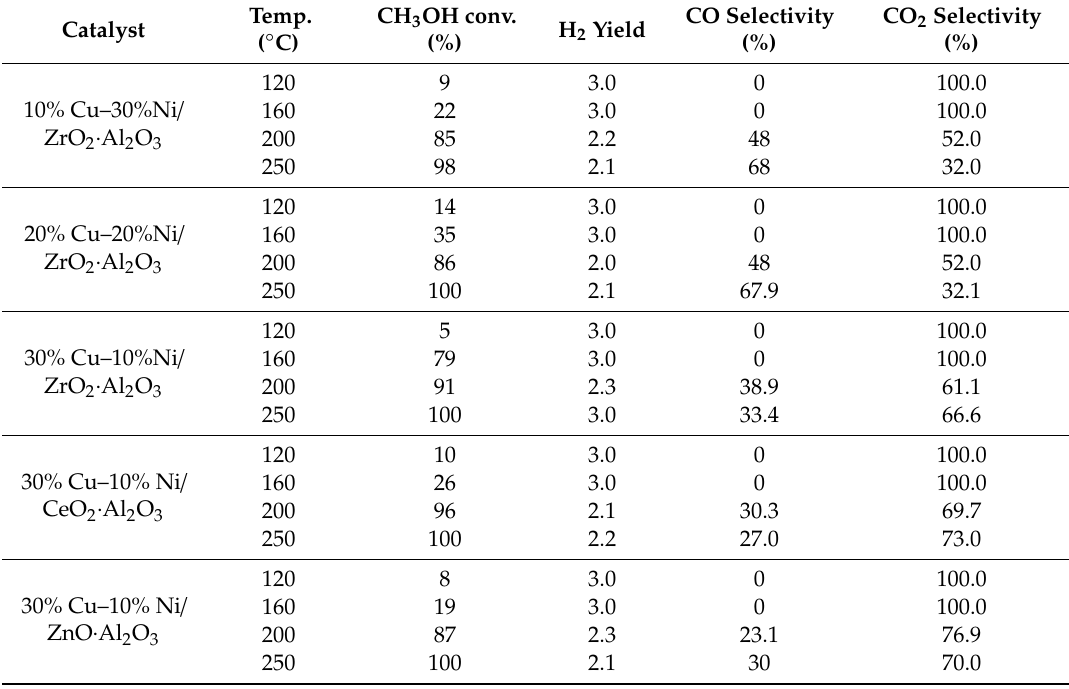
Table 1. Results of the oxidative steam reforming process for calcined bimetallic catalysts. Temp. CH 3 OH Catalyst ( ◦ C)